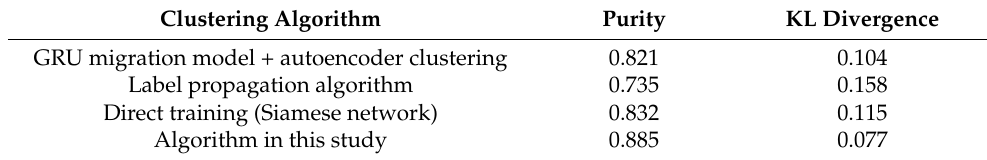
Table 6. Clustering